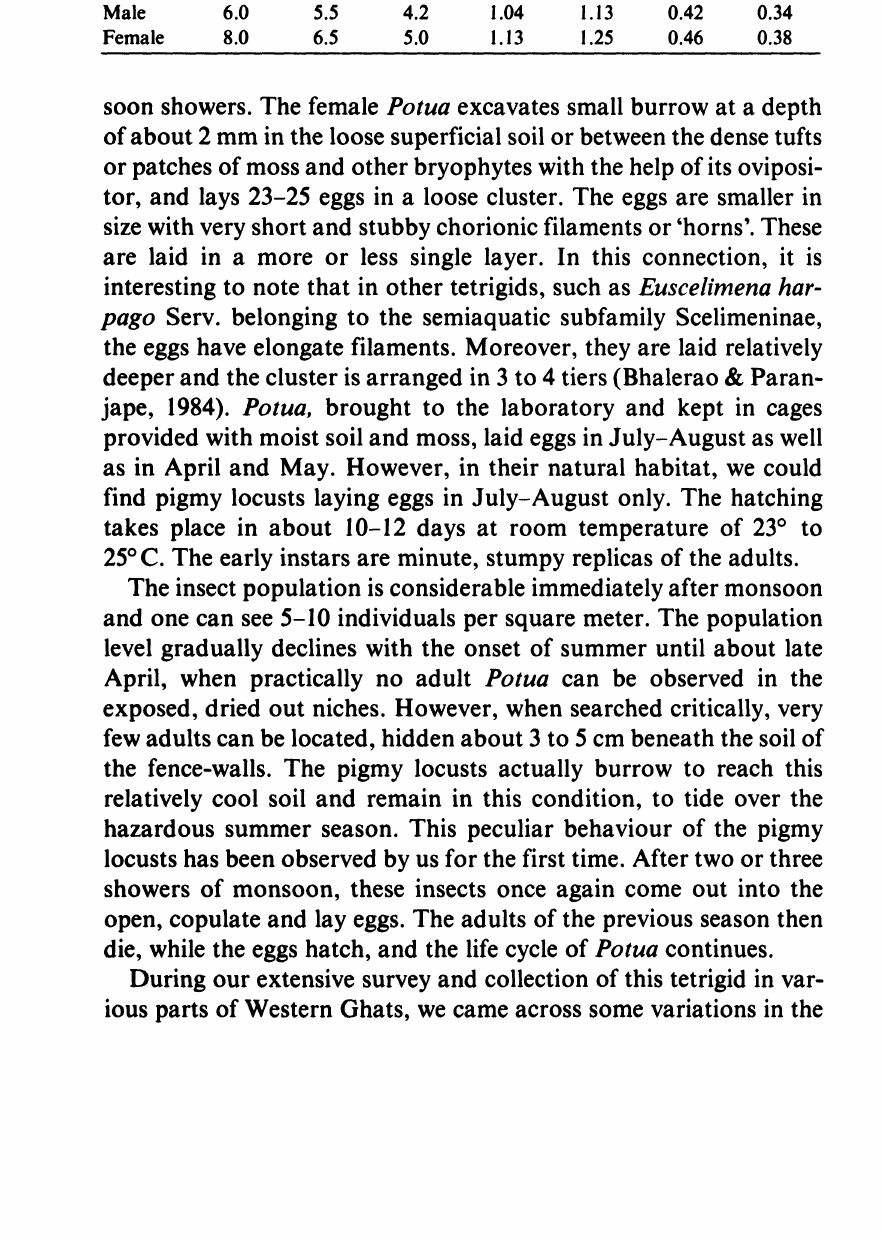
Table 2. Average measurements in mm of various body parts in 10 specimens of Potua sabulosa Hancock Length Breadth Fore Fore Hind wings Hind wings Hind Sex Body Pronotum femur (Elytra) wings (Elytra) wings Male 6.0 5.5 4.2 1.04 1.13 0.42 0.34 Female 8.0